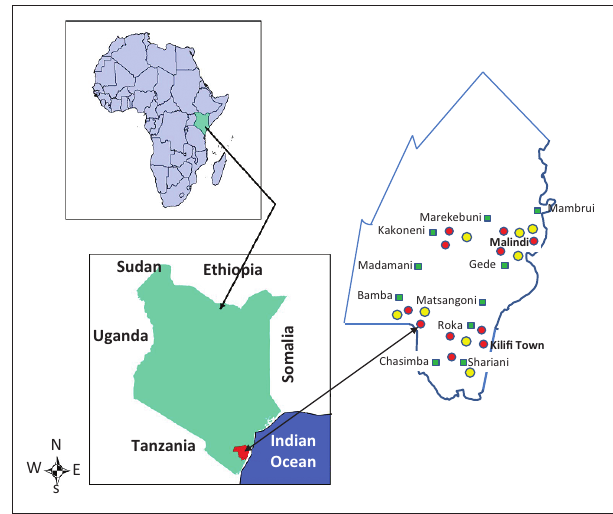
FIGURE 1: Map of Kilifi County showing the locations of the self-help groups